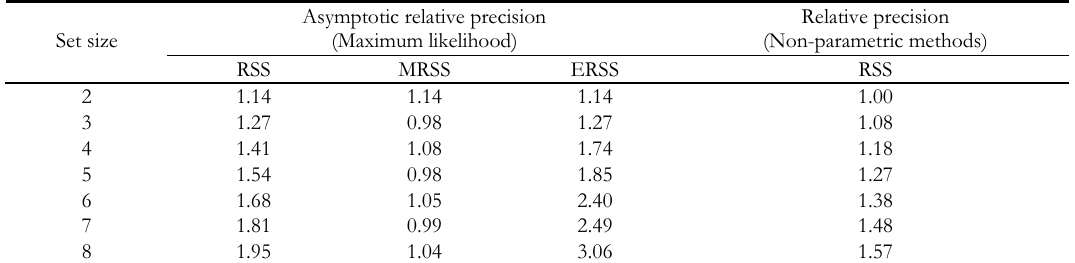
The asymptotic relative precision and relative precision values for estimators of (cid:86) from N (0, (cid:86) 2 )